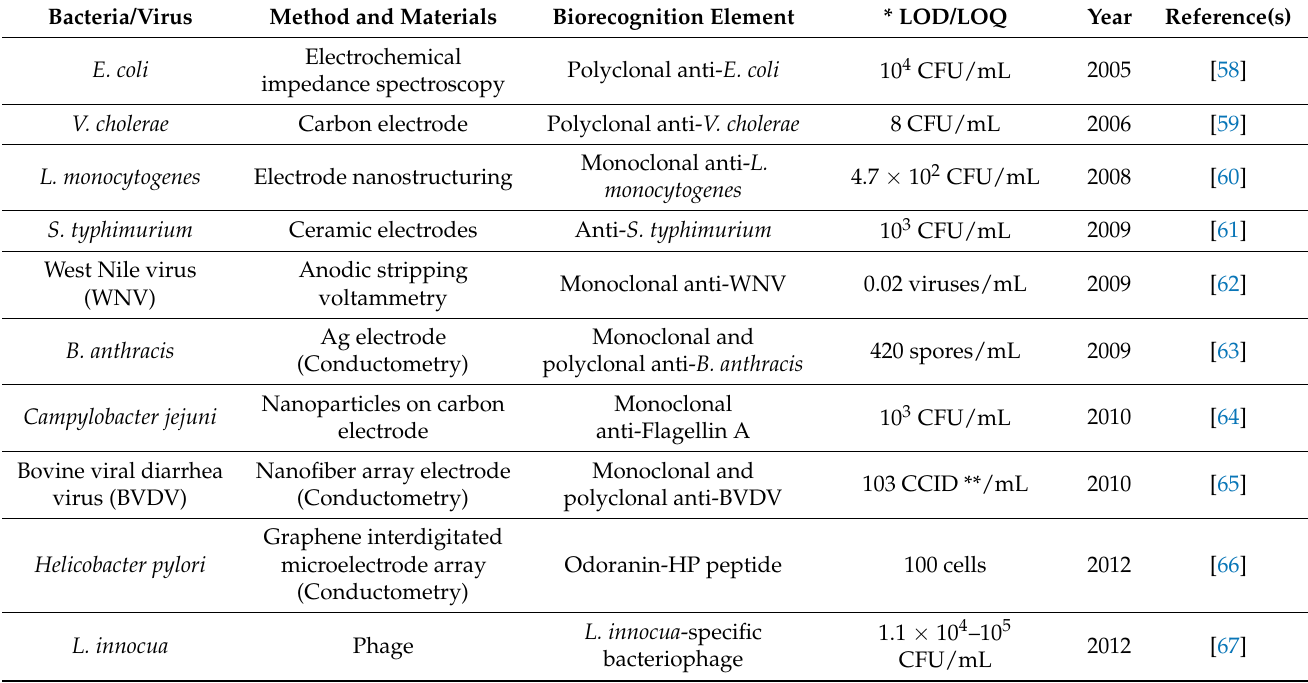
Table 2. Chronological table of biosensor usage for bacterial or viral